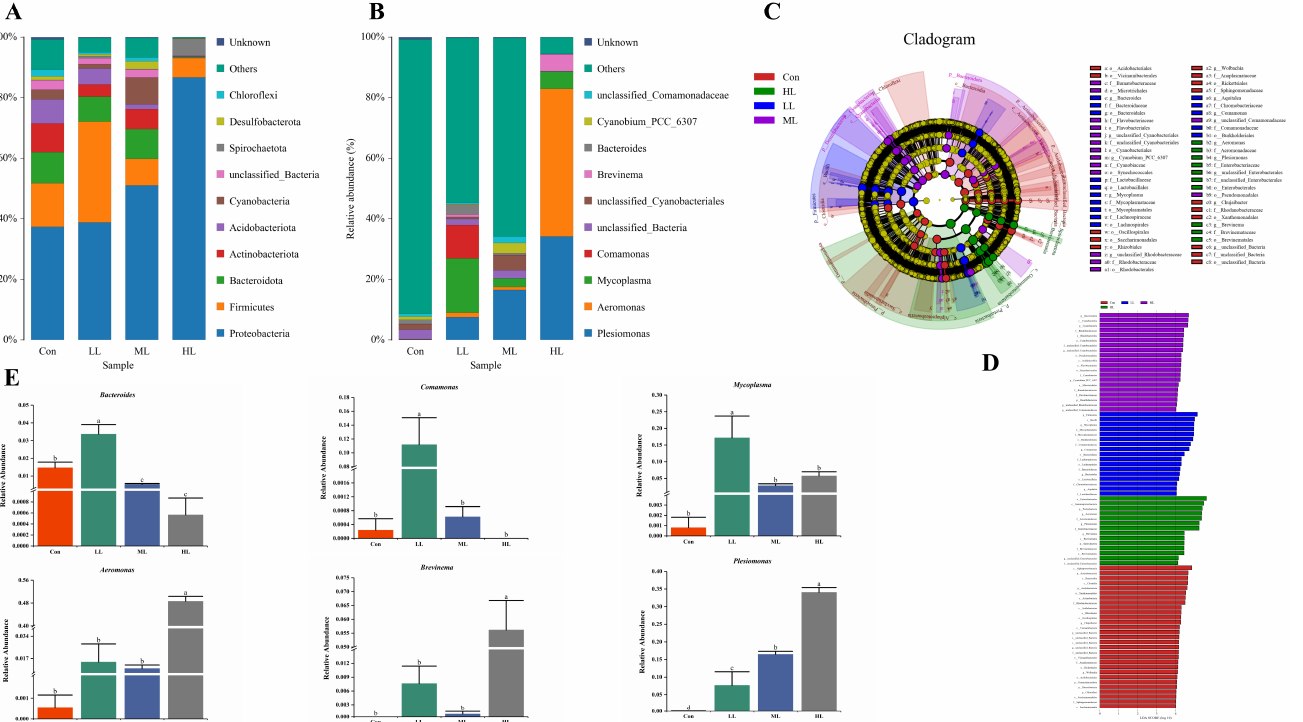
Figure 5. Intestinal microbiota changes between control and laminarin supplemented groups of juvenile largemouth bass. ( A ) The bar plots at phylum level. ( B ) The bar plots at genus level. ( C ) The Lefse analysis of differential flora between control and laminarin Scheme 4. 0. ( D ) The LDA scores of different microbes between control and laminarin supplemented groups. ( E ) The relative abundance of microbes with significant difference. Values in rows with different superscript letters have significant differences ( p < 0.05). Con means control diet. LL, ML, and HL mean 5 g Kg − 1 , 10 g Kg − 1 and 15 g Kg − 1 laminarin was supplemented into diets,